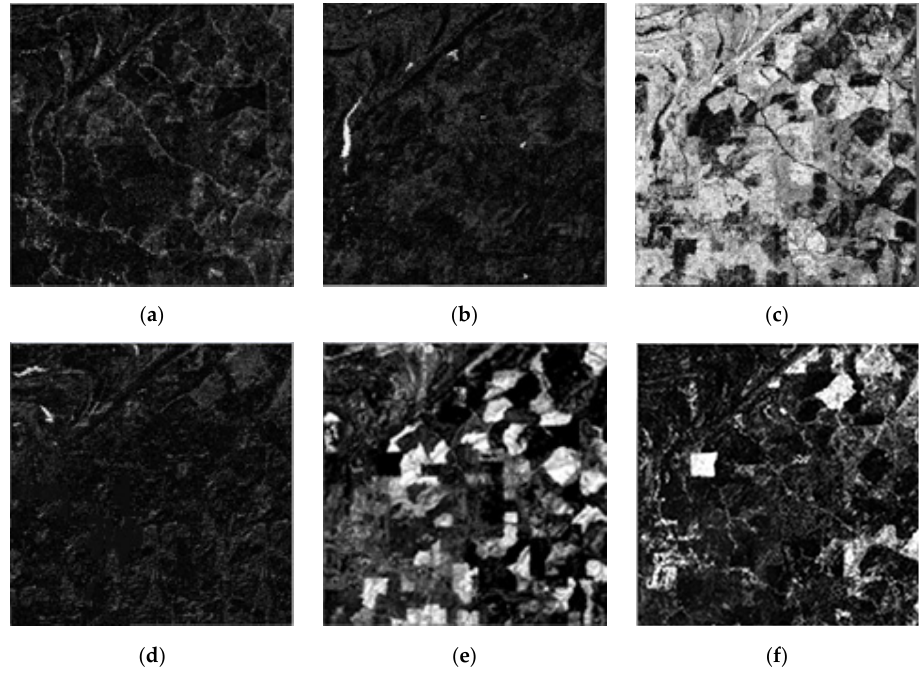
Figure 11. The abundances in the entire image: ( a ) bare soil (B), ( b ) rivulet (R), ( c ) agricultural crop (A), ( d ) agricultural crop–rivulet (AR), ( e ) agricultural crop–bare soil (AB) and ( f ) bare soil–agricultural crop (BA).